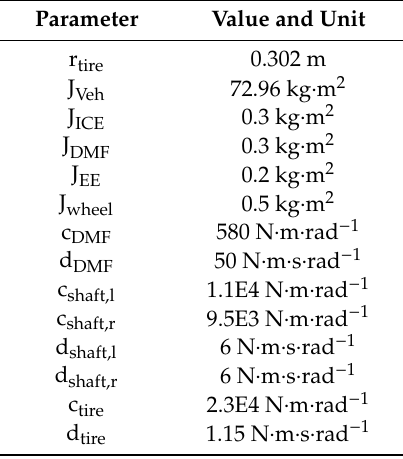
Table A4. Parameters of the torsional vibration model.